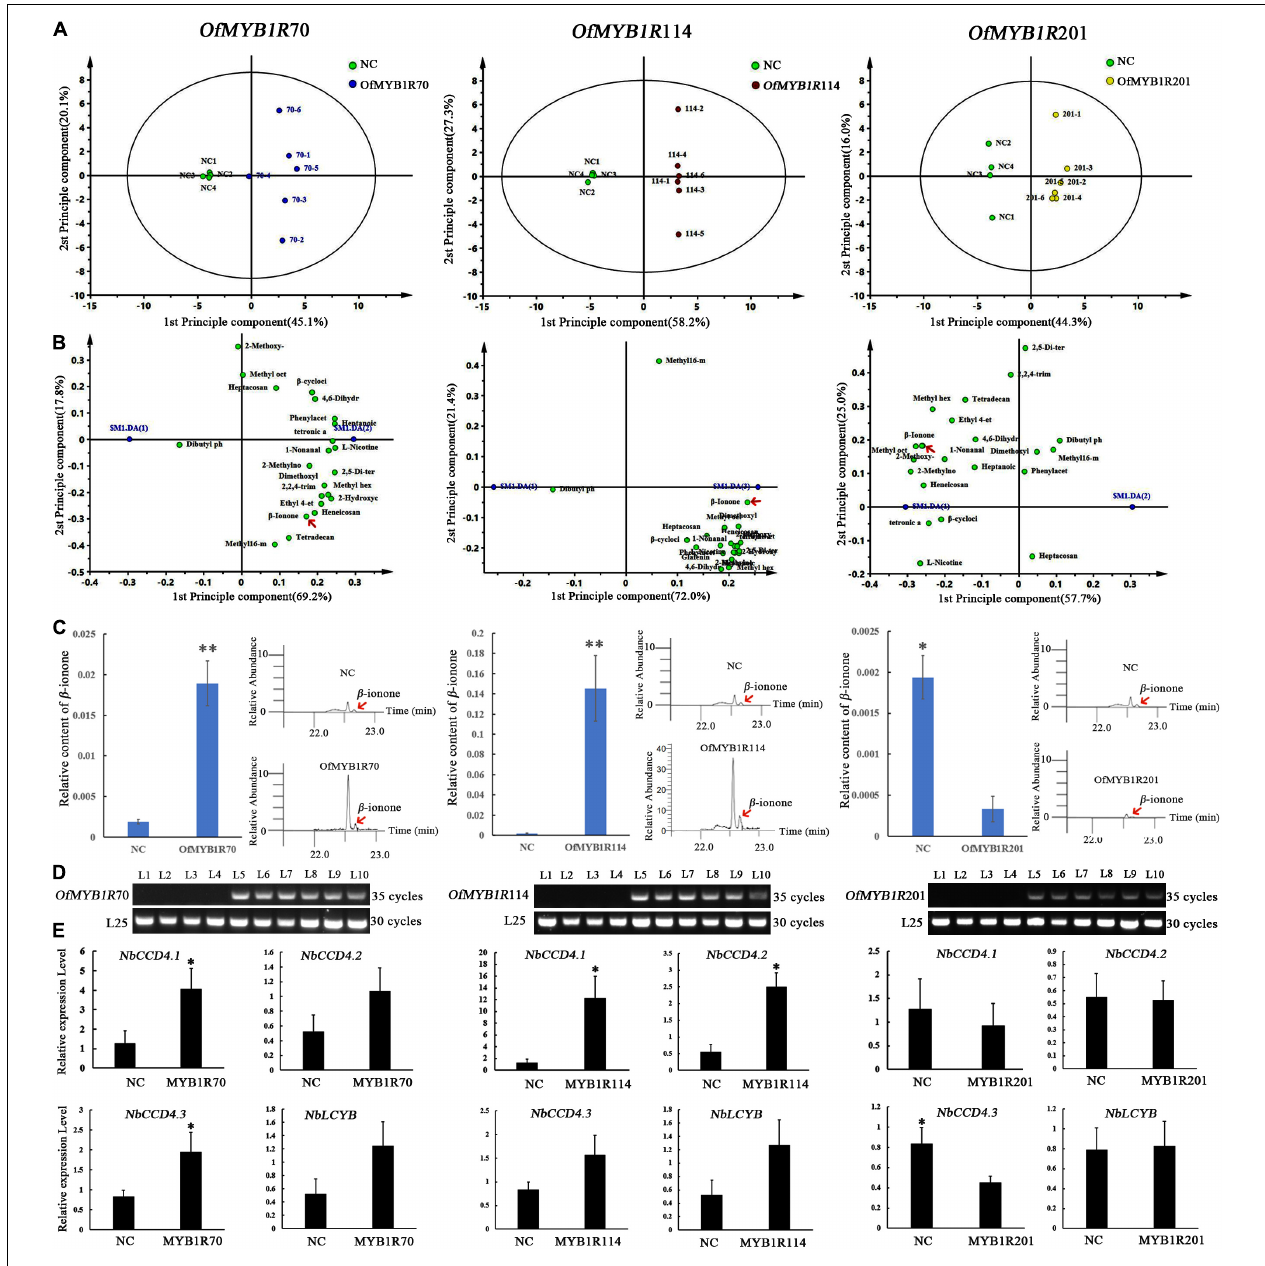
FIGURE 7 | Score scatter plot of the leaf GC-MS profiles of three types plants with transient expression of different MYB1R transcription factors in in tobacco, determined with PCA-X analysis in SIMCA13.0 (A) . Loading scatter plot analysis of floral VOCs in plants after infiltration of 35S: OfMYBMYB1R70/114/201 :GFP and control vectors. The red arrow marks the floral aroma in plants with transient expression (B) . Floral composition analysis of β -ionone after infiltration with 35S: OfMYBMYB1R70/114/201 :GFP and control vectors (C) . RT-PCR to explore the regulation of gene transcription OfMYBMYB1R70/114/201 levels. A fragment of the NbL25 gene was amplified as an internal control. L1–4 represent different plants infiltrated with empty vectors, and L5–10 represent different plants infiltrated with 35S: OfMYB1R :GFP vectors (D) . qRT-PCR analysis of the NbCCD4 transcript levels in control and transiently transformed tobacco leaves (E) . ∗ P < 0.05, ∗∗ P <